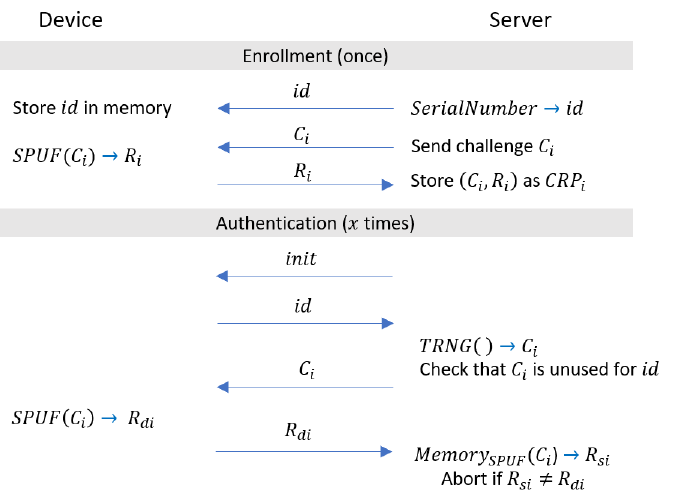
Figure 3. Basic protocol to authenticate a device towards a server using